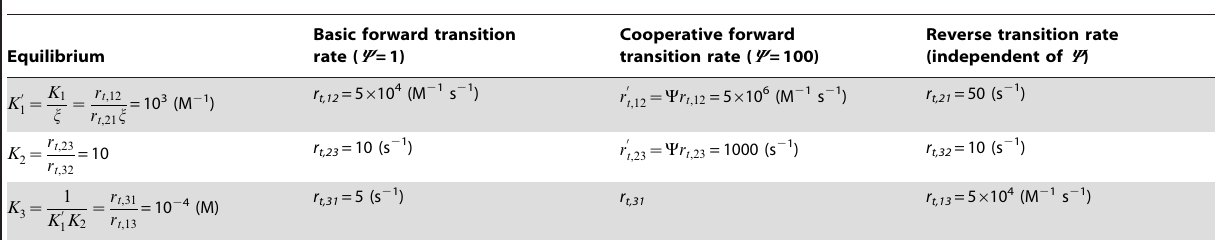
Table 3. Thin-filament transition rates ( j =100).